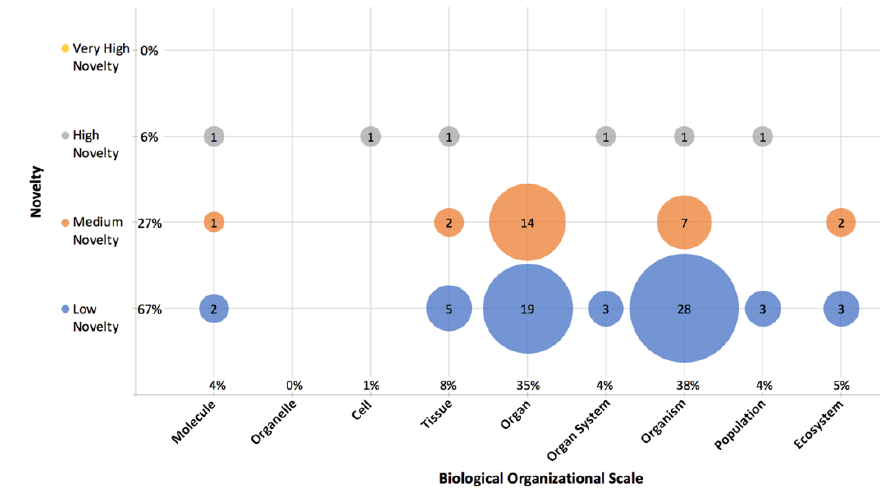
Figure 5. Novelty Distribution of Biomimetic Structures and Materials ( n = 95).